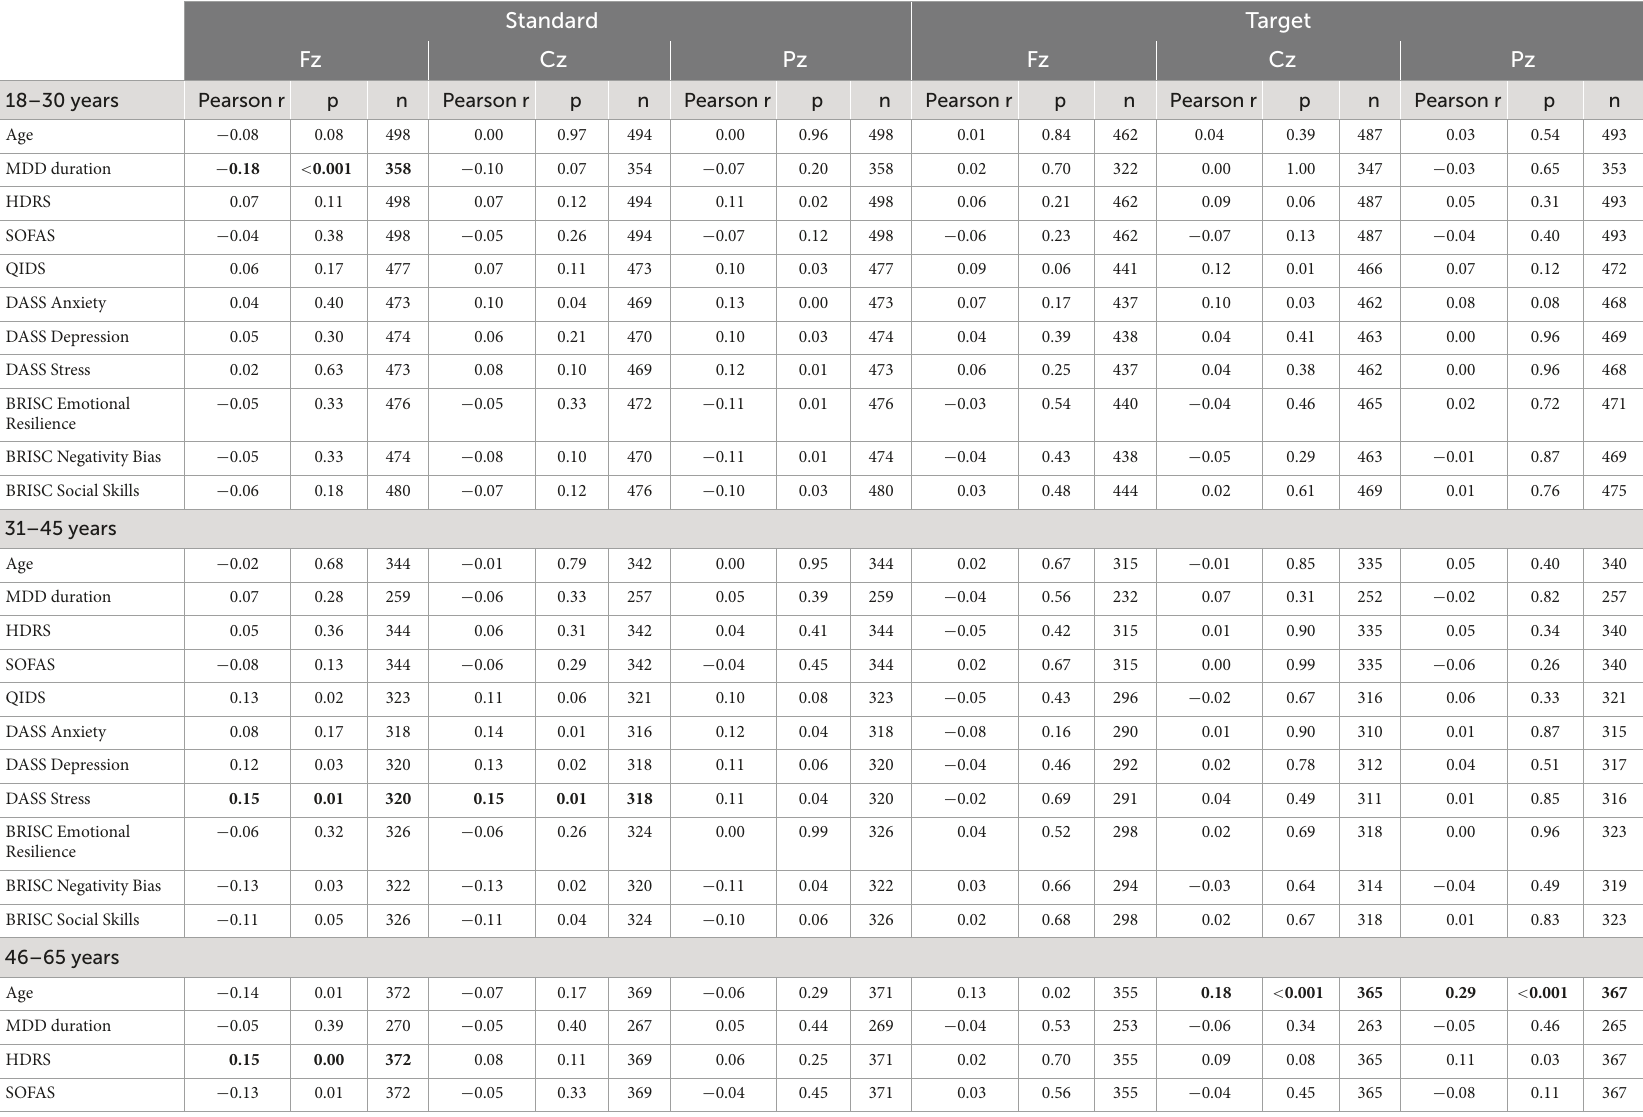
TABLE 4 Correlations between the P300 latency at the Fz, Cz, and Pz locations in response to standard and target sounds and behavioral